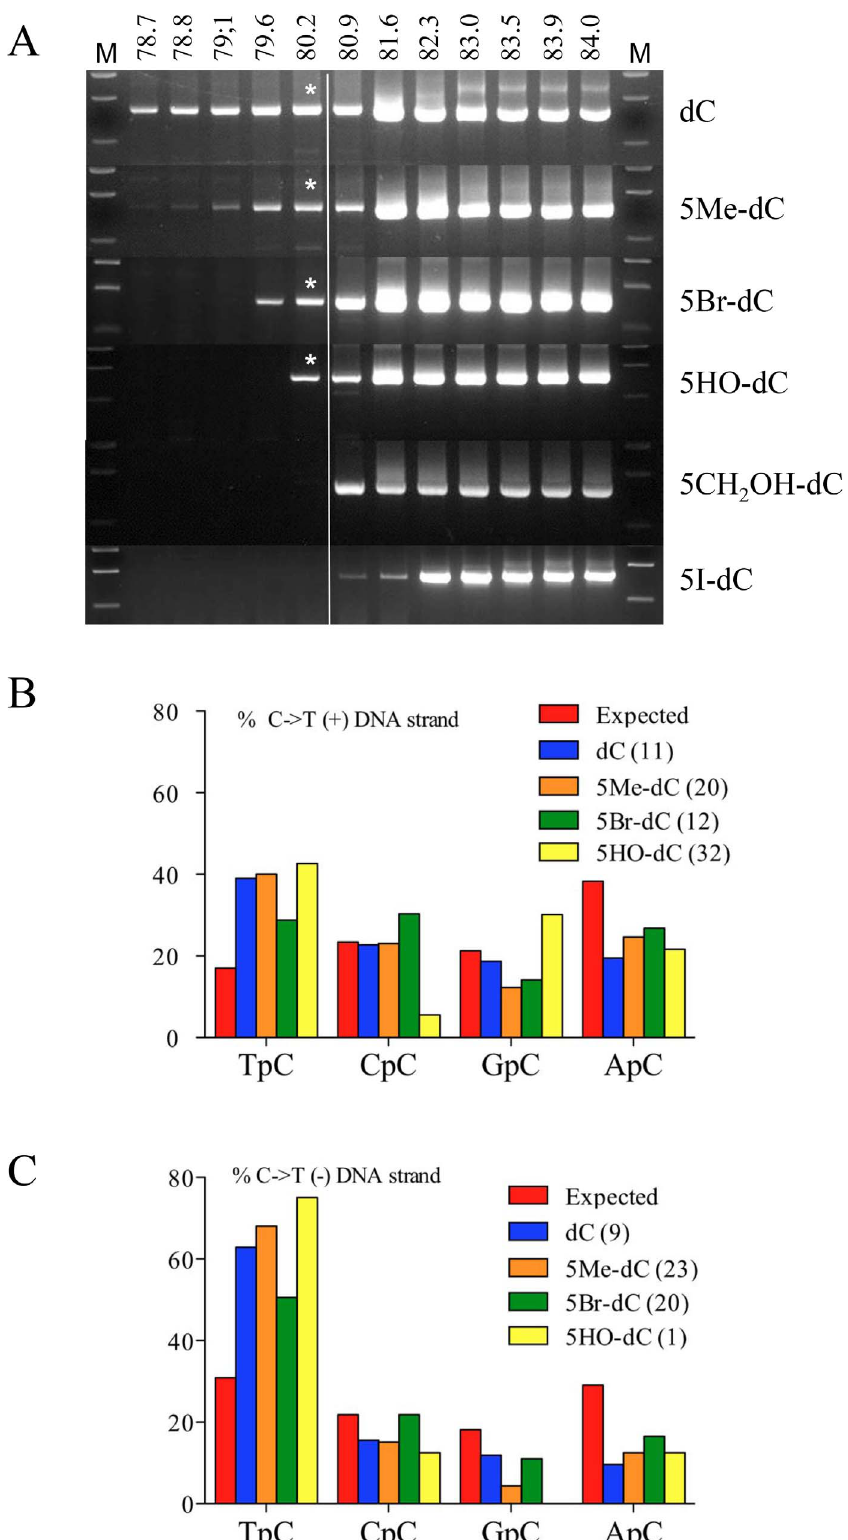
Figure 4. A3A can deaminate 5 bromo- and 5 hydroxy-cytidine ssDNA derivatives. A) 3DPCR analysis of recovered HIV DNA. Only for the 5Me, 5Br and 5HO derivatives were deaminated products recovered. Asterisks denote the 3DPCR products cloned and sequenced. B) 5 9 Dinucleotide analysis of the deamination context. For both strands a clear preference for TpC was evident.